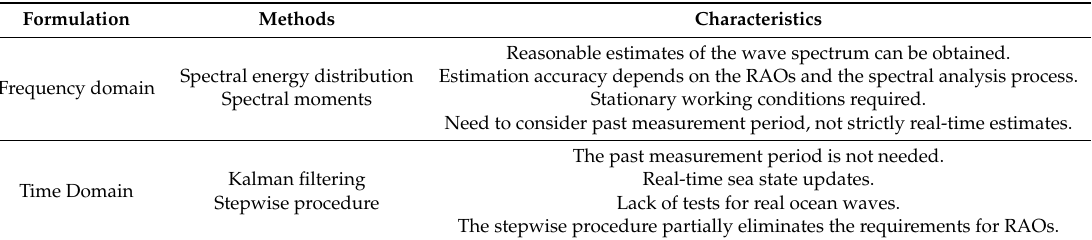
Table 1. Comparison of wave spectrum estimation formulations using the wave buoy